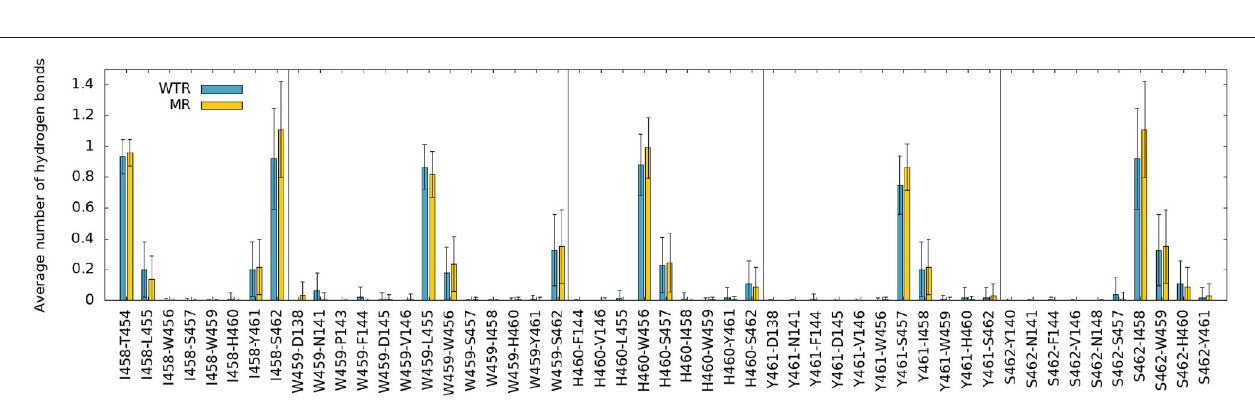
FIGURE 4 | Hydrogen bonds of M4 tip residues (I458, W459, H460, Y461, S462), calculated over R01-400 for the WTR (blue) and the MR (yellow).